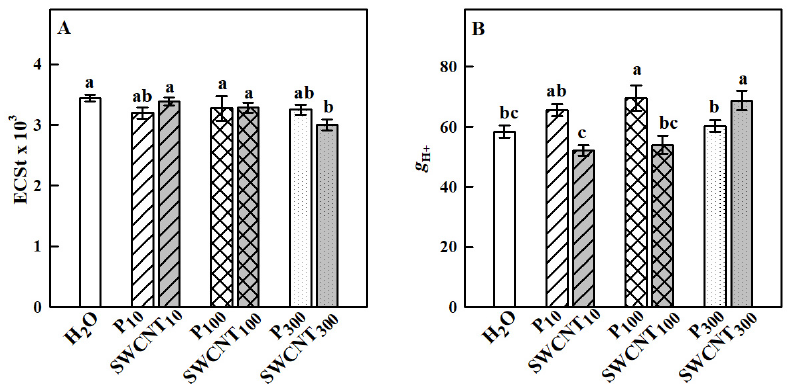
Figure 6. Total size of the thylakoid proton motive force ( pmf ) formed in the light estimated by the ECSt parameter ( A ) and proton efflux ( ǥ H+ , B ) governed mainly by the chloroplast ATP synthase activity. Data were recorded seven days after spraying with “Pluronic” P-85 (P 10,100,300 ) and SWCNTs (SWCNT 10,100,300 ). Plants sprayed with H 2 O served as the control. Data are means ± SE ( n = 6). One-way analysis of variance (ANOVA) with a between-subjects factor was performed to assess statistically significant mean differences. Mean separation was performed using a Tukey’s test and statistically different means at the 5% level ( p < 0.05) are indicated with different letters.